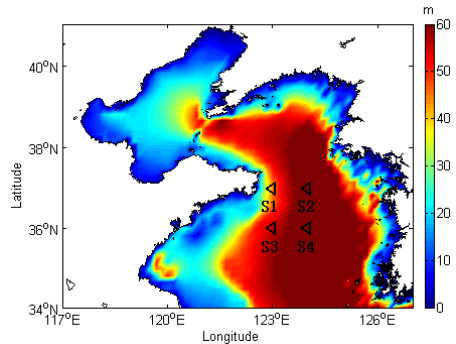
Figure 1. Bathymetry of the study region and four study sites (black triangles).